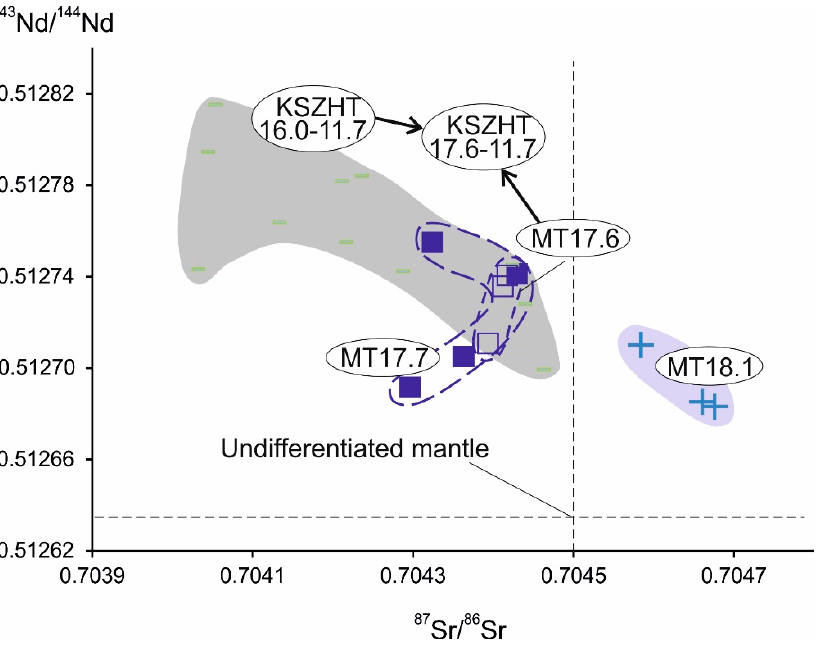
Figure 13. 143 Nd/ 144 Nd– 87 Sr/ 86 Sr diagram showing points of the initial eruption phase from a garnet-free source (MT18.1) in the Meteo Volcano, the intermediate phase from the garnet-free and garnet-bearing sources (MT17.7), and the final phase of this volcano (MT17.6). The latter is comprised with a set of younger volcanic rocks from garnet-free and garnet-bearing sources (KSZHT16.0–11.7) into a common array (KSZHT 17.6–11.7). Symbols are as in Figure 9.